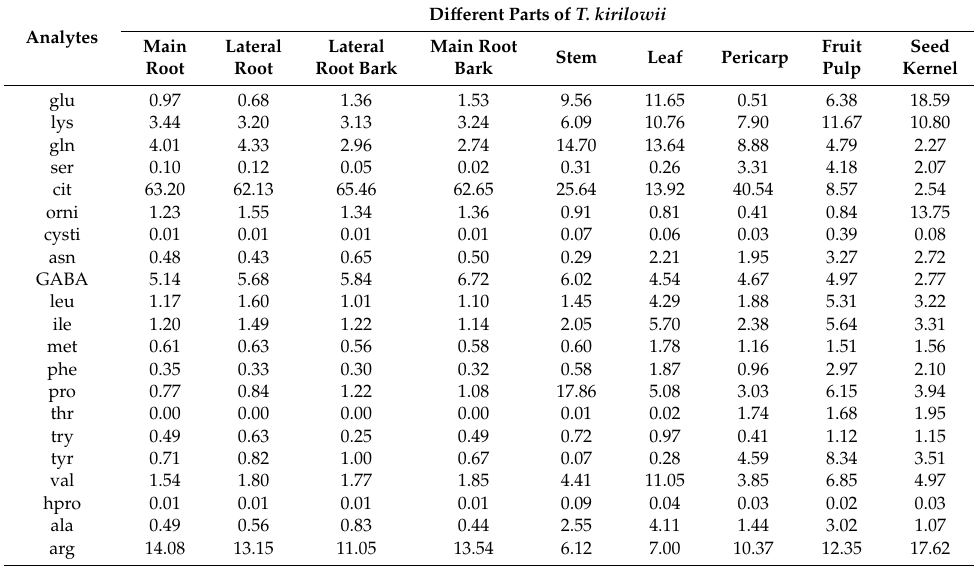
Table 3. Proportion of the relatively abundant analytes in total amino acids (%).